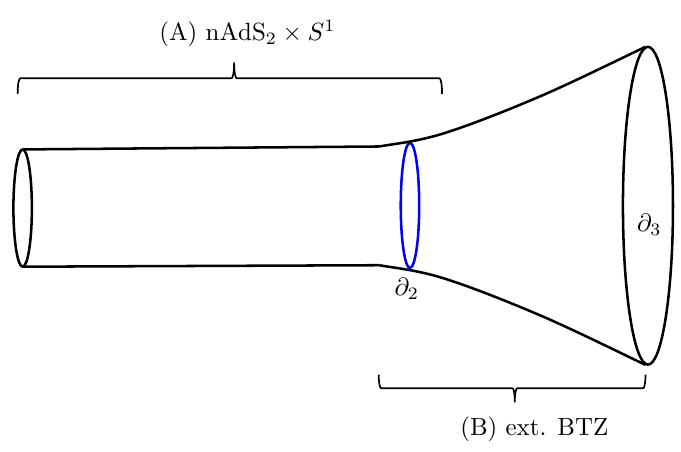
Figure 5 . The near extremal BTZ geometry at (cid:12)xed time, from the horizon (leftmost circle) to the asymptotically AdS 3 boundary (rightmost circle @ 3 ). In region (A) the geometry is approximately nearly AdS 2 (cid:2) S 1 (described by JT gravity), and in (B) the geometry is approximately extremal BTZ and the physics is classical. In the overlap between (A) and (B), we introduce the boundary @ 2 (the blue line) where the Schwarzian mode